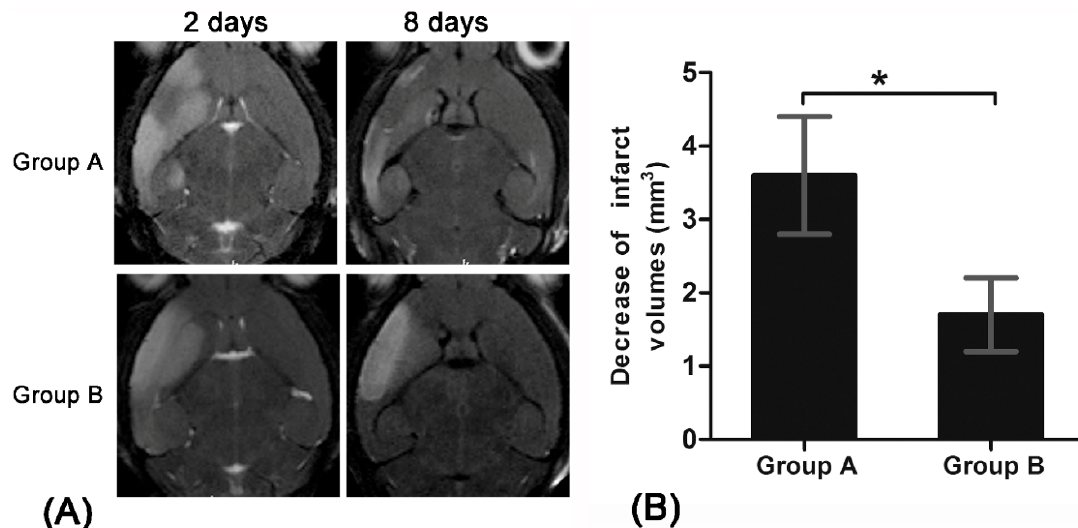
Figure 3 . Infarct volumes in pure stroke mice and stroke mice treated with Ara-C. T2- Figure 3. Infarct volumes in pure stroke mice and stroke mice treated with Ara-C. T2-weighted MR weighted MR images show hyperintense signal of the cerebral infarction on T2-weighted images show hyperintense signal of the cerebral infarction on T2-weighted MR images ( A ); Graphs MR images ( A ). Graphs show infarct volume decrease measured in pure stroke mice (group A) show infarct volume decrease measured in pure stroke mice (group A) and stroke mice treated with and stroke mice treated with Ara-C (group B) between 2 days and 8 days after the stroke Ara-C (group B) between 2 days and 8 days after the stroke ( B ). * p < ( B ). * p < 0.05.